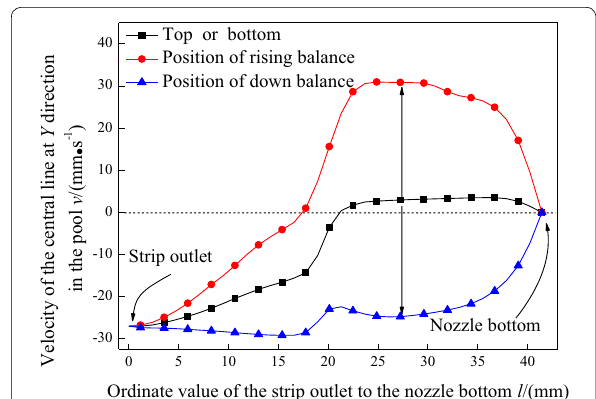
Figure 6 Velocity of the central line in the Y direction in one oscillation cycle